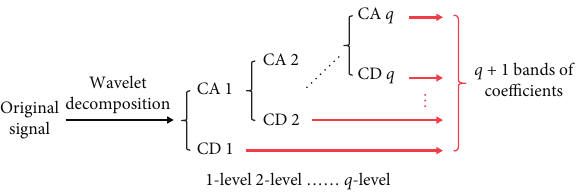
Figure 2: The wavelet decomposition of